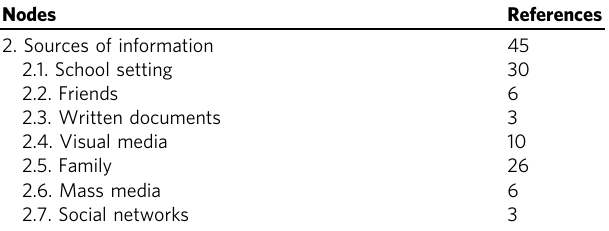
Table 11 Respondents ’ narratives: Number of references for different sources of information. Nodes